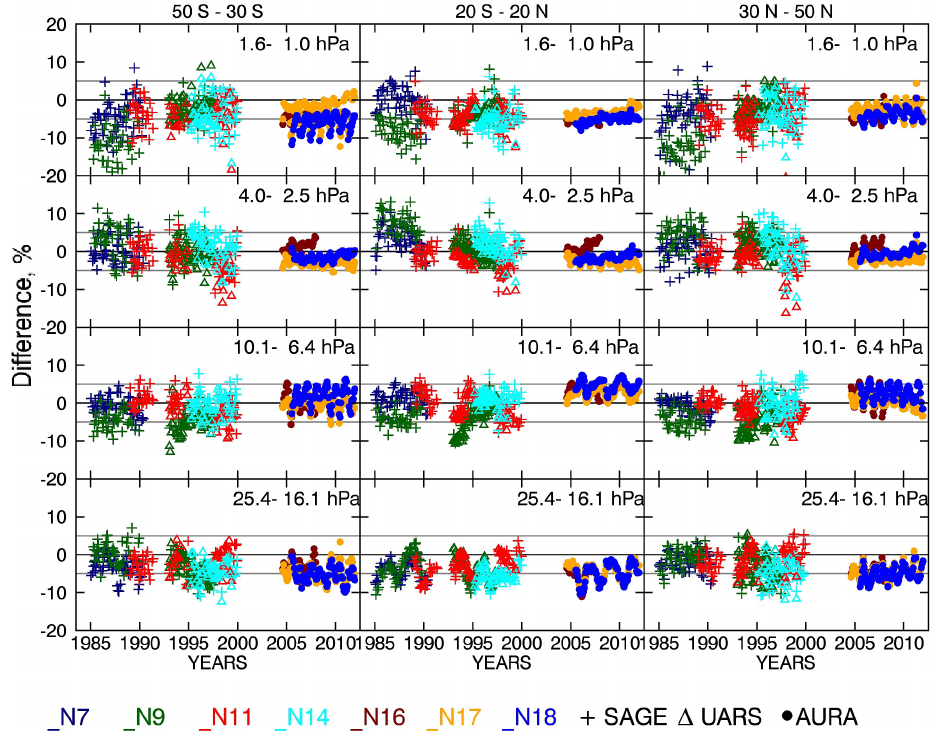
Fig. 3. Time series of differences for individual SBUV instruments relative to SAGE, UARS and Aura MLS for three latitude bands (30– 50 ◦ S, 20 ◦ S–20 ◦ N and 30–50 ◦ N) and four layers between 25 and 1hPa. SAGE measurements overlap with N7, N9, N11 and N14 over the period 1984 to 1999; UARS MLS overlaps with N9, N11 and N14 over the period 1993 to 1999; and Aura MLS overlaps with N16, N17 and N18 over the period 2004 to 2011. Colors correspond to individual SBUV instruments. Differences relative to SAGE are marked as crosses, relative to UARS MLS as triangles and relative to Aura MLS as filled